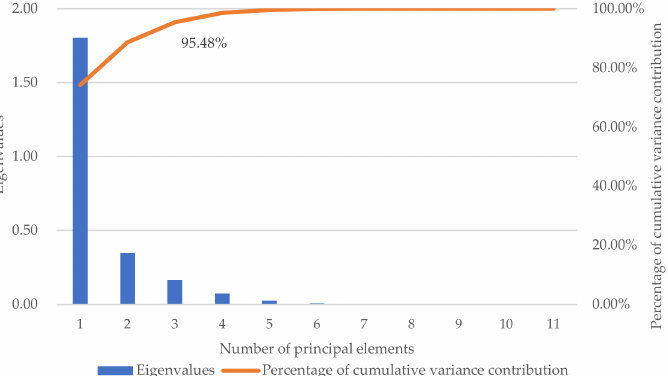
Figure 4. Cumulative variance contribution of the seismic attributes of kernel principal component analysis in the exploration stage.